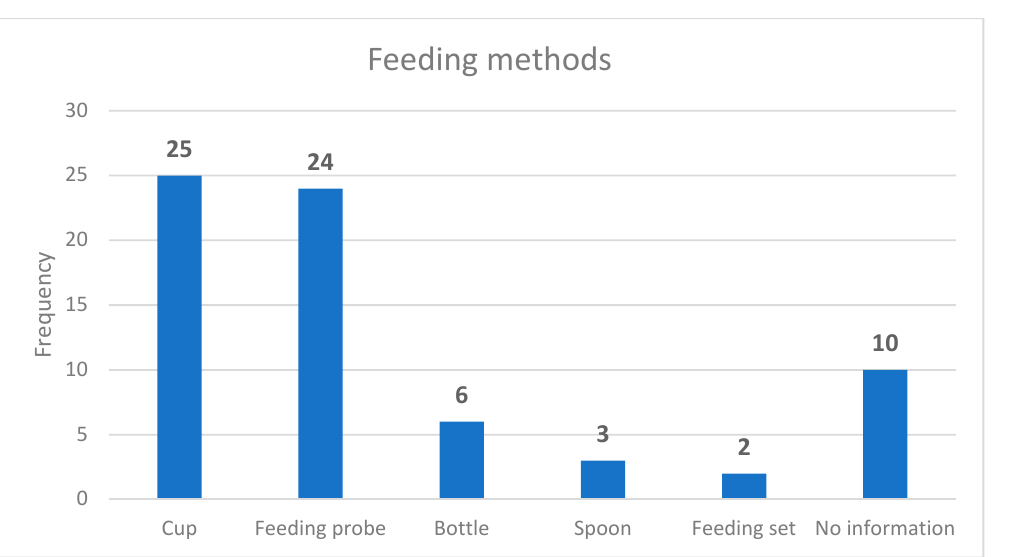
Figure 1. Feeding methods for supplemental feeding.